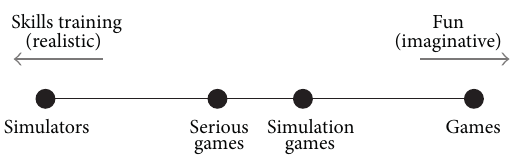
Figure 1: The computer game